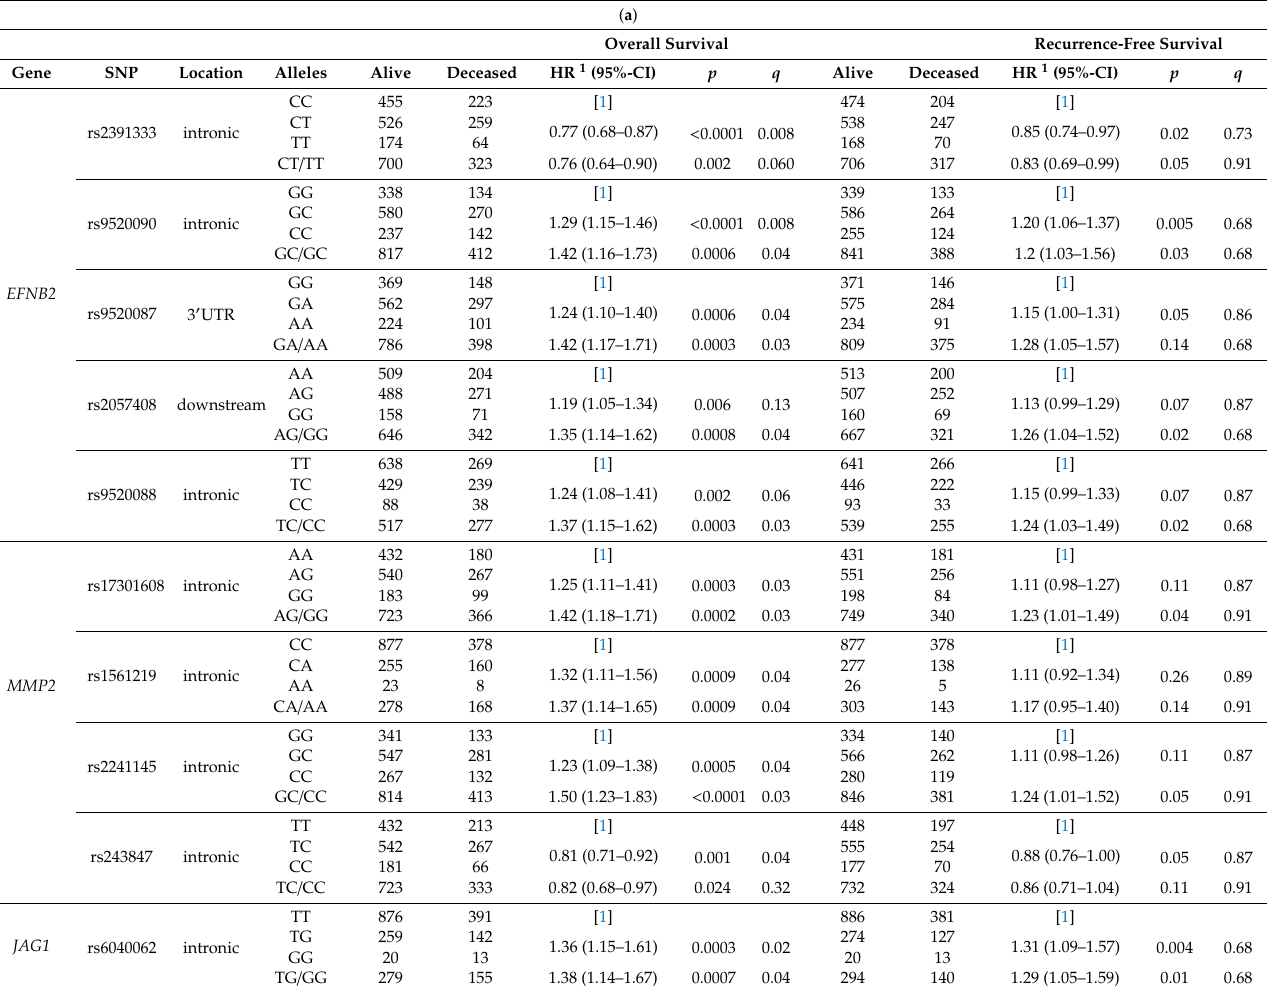
Table 2. Significant associations of genetic variants in MMP2 , EFNB2 and JAG1 with overall and recurrence-free survival of colorectal cancer patients in the discovery cohort. ( a ) Associations of tagging SNPs; ( b ) Association of candidate